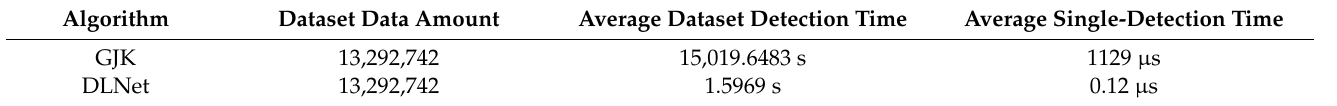
Table 4. Single self-collision detection time comparison of DLNet and GJK.